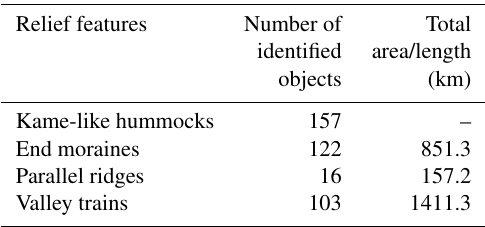
Table 4. Remote mapping of the glacial and fluvioglacial relief fea- tures in the Nadym River basin (mid and lower